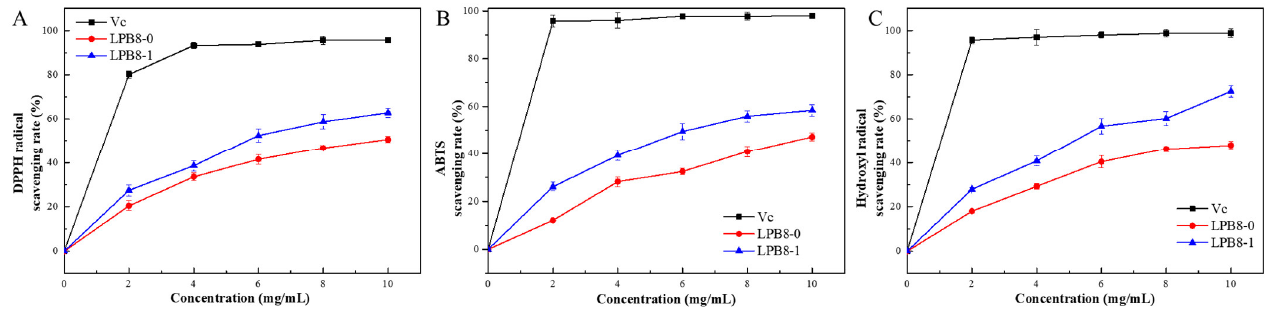
Figure 7. The antioxidant activities of LPB8-0 and LPB8-1 using VC as a control: scavenging activity towards DPPH ( A ); ABTS radical ( B ); hydroxyl radical ( C